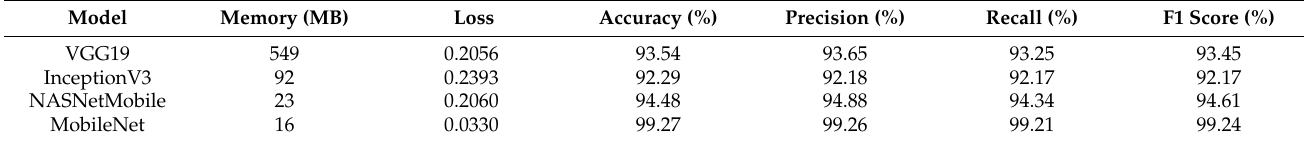
Table 6. Performance comparison of different classification